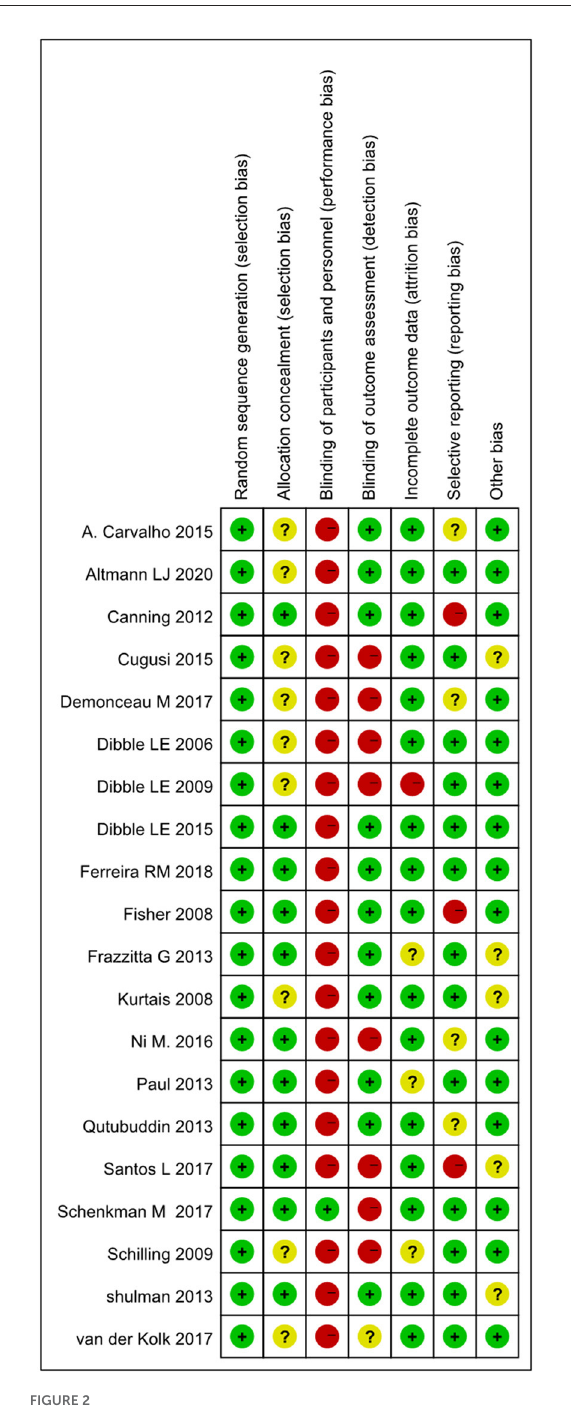
FIGURE2 Combined percentage risk of bias in each risk domain for all included